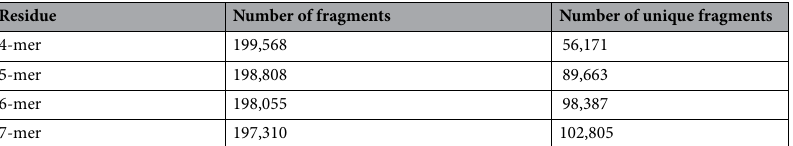
Table 3. The numbers of peptides derived from edible proteins by performing in silico protease digestion using all available proteases in the database. After removing duplicate sequences, the final number of peptides is shown in the right